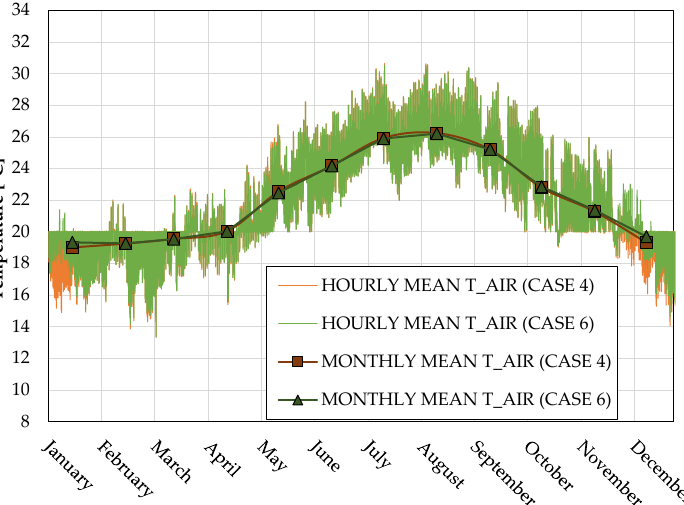
Figure 16. Comparison of average hourly and monthly average indoor air temperatures in the THU between CASE 4 and CASE 6.